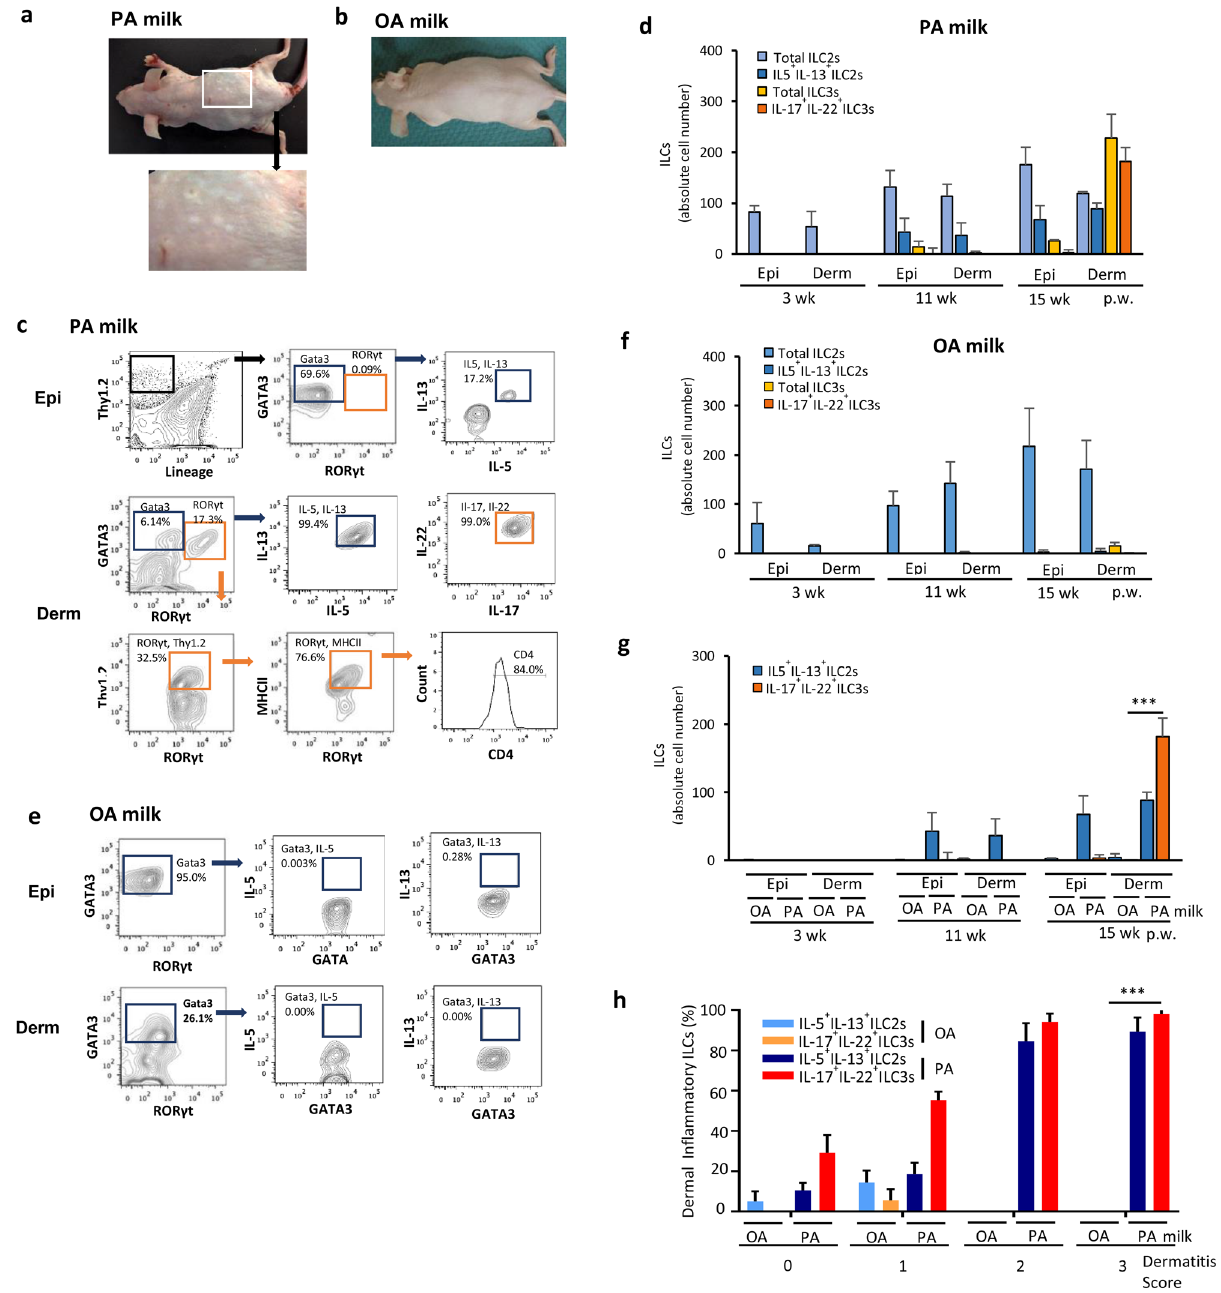
Figure 4. Inflammatory ILC3s was increased in the dermis of PA milk mice. ( a , b ) Pictures of ( a ) PA milk and ( b ) OA milk mice taken at 15 weeks post weaning (p.w.). ( c , e ) Representative FACS analysis of ( c ) PA milk and ( e ) OA milk at 15 weeks p.w. Epidermis and dermis ILCs of mice at 3, 11 and 15 weeks p.w. were isolated separately. Cells were stained with Thy1.2 and lineage markers (NK1.1, T cell receptor TCRβ and TCRγδ, CD11b, CD19, CD8, Gr-1 and Ter119). ILCs were gated by Lin − and Thy1.2 + expressions, intracellularly stained for GATA3 (ILC2s) and RORγt (ILC3s), and interleukins (IL-5, IL-13, IL-17A and IL-22). ( d , f ) Absolute ILCs number and their respective interleukins in the IEL and LP at the indicated p.w. (n = 5 mice/group) were represented in bar graph as means ± SD. ( g ) Comparison of the inflammatory ILCs in the epidermis and dermis of OA and PA milk. In OA-milk data, most of ILC cell number is not detected. ( h ) Percentages of inflammatory ILC2s and ILC3s in association with dermatitis score of OA or PA milk mice at 15 weeks post-weaning. Results shown are representatives of at least three independent experiments. Normal diet group (ND) data is almost same as OA milk group results. Data are represented as mean ± SD. *** P < 0.001, one-way ANOVA. Data are analyzed with Prism8 (version 8.4.3, https:// www. graph pad. com/ scien tific- softw are/ prism), and FlowJo (version 10.7.1, https:// www. flowjo. com/ solut ions/ flowjo/ downl